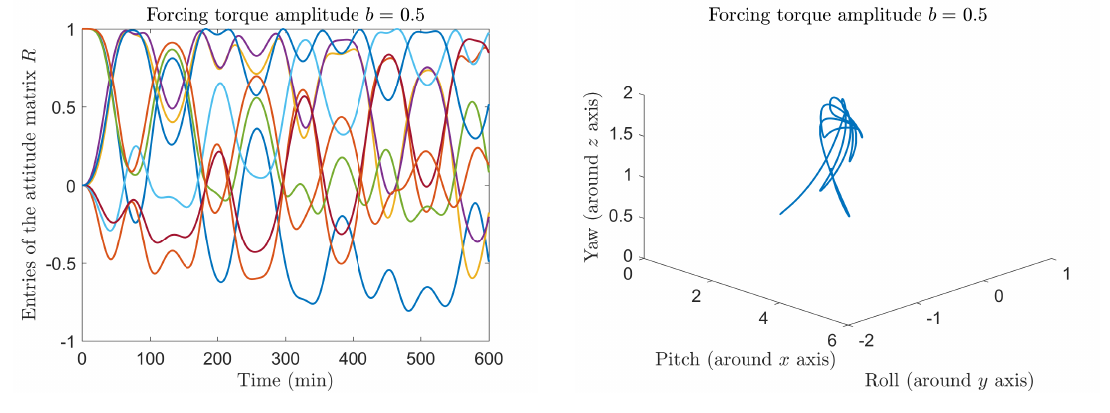
( a ) Entries of the attitude matrix R over time. Figure 5. Numerical experiment: trajectory of a satellite gyrostat with stabilizing control switched off. (The angles, expressed in radians, were unrolled for better